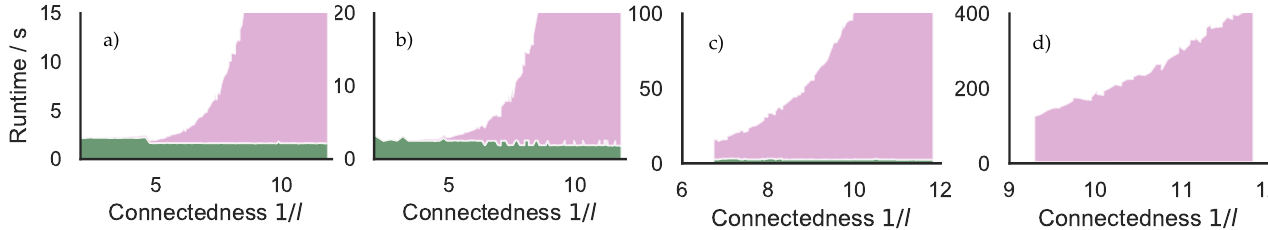
Figure 8. Runtimes of the DisCOptER algorithm in seconds, split into the discrete part (pink, top) and the continuous part (green, bottom), sampled with h = l 2 . Constant accuracy δτ = 1/300. Subfigures refer to the corresponding test